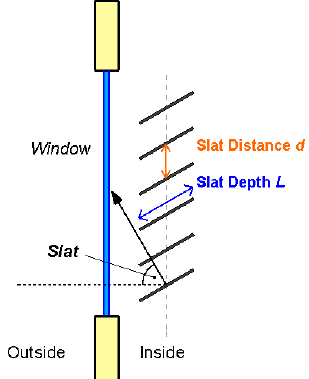
Figure 1. Schematization of venetian blinds.